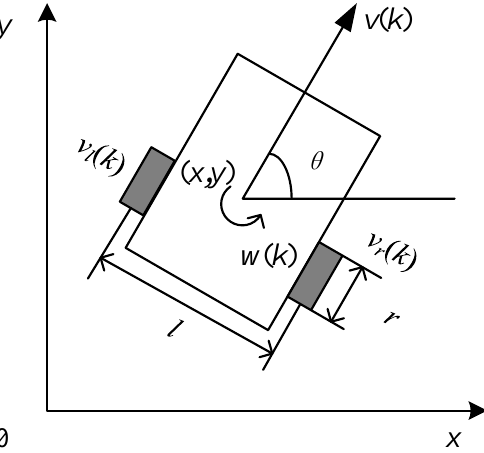
Figure 8. Schematic diagram of second-order differential robot (27). The v ( k ) and w ( k ) denote the velocity and angular velocity, respectively. The v l ( k ) and v r ( k ) represent the left and right wheel velocities, respectively. The global position coordinates are denoted by ( x , y ) . l denotes the distance between the left and right wheels, r is the wheel radius [45]. The left and right wheel velocities v l ( k ) and v r ( k ) are selected as the control variables, and the dynamic model is obtained as shown in